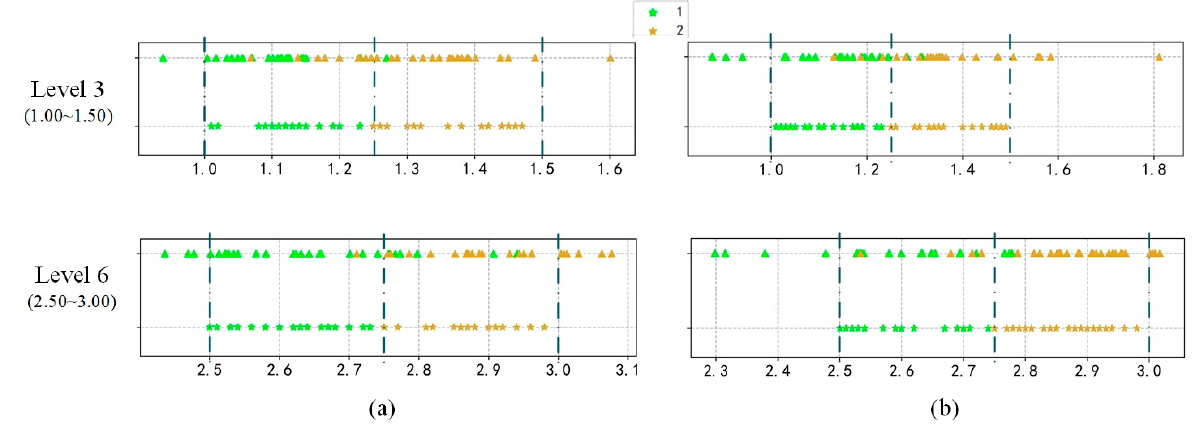
Figure 10. The distribution of 50 randomly sampled values in levels 3/6 from the INDF dataset, where the star pattern ‘ ⋆ ’ represents the ground truth and the triangle pattern ‘ ▲ ’ represents the prediction value in each level, with the regression method ( a ) or VISOR-NET ( b ). Table 9. The regression results at each level for two methods.